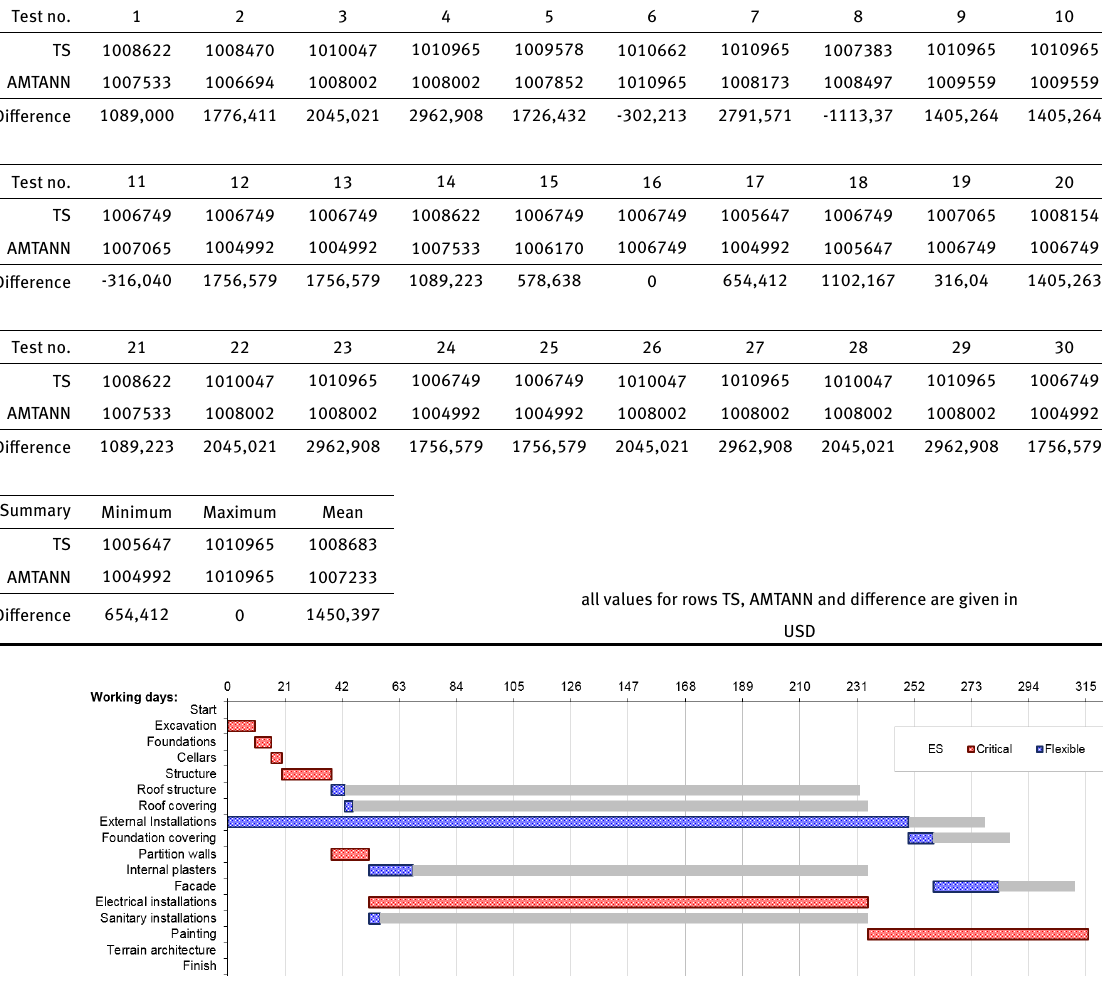
Table 3: Results comparison.